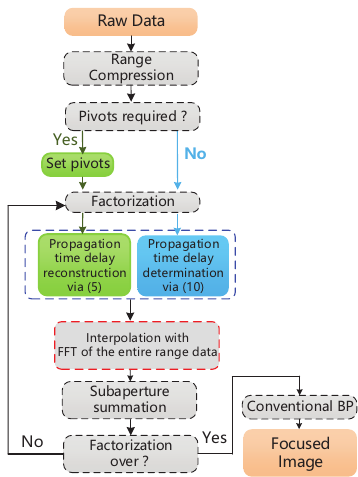
Figure 5. Flowchart of the proposed algorithm. In this flowchart, the MoBulk_FFBP and BiBulk_FFBP are integrated together. Mo, monostatic; Bi, bistatic; FFBP, fast factorization